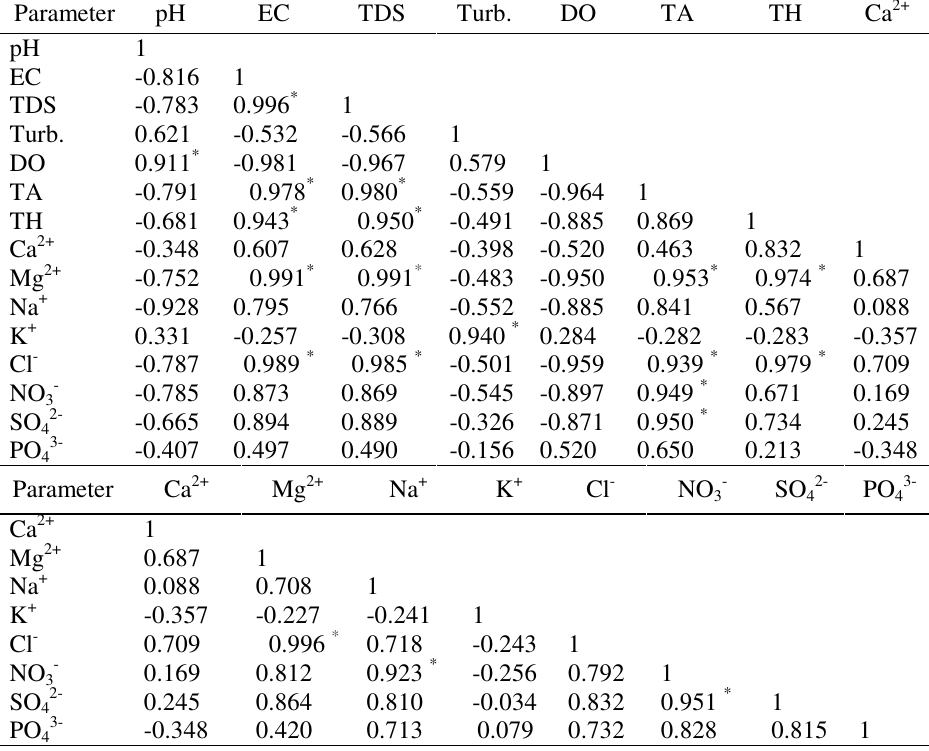
Table 3. Correlation matrix for different water quality